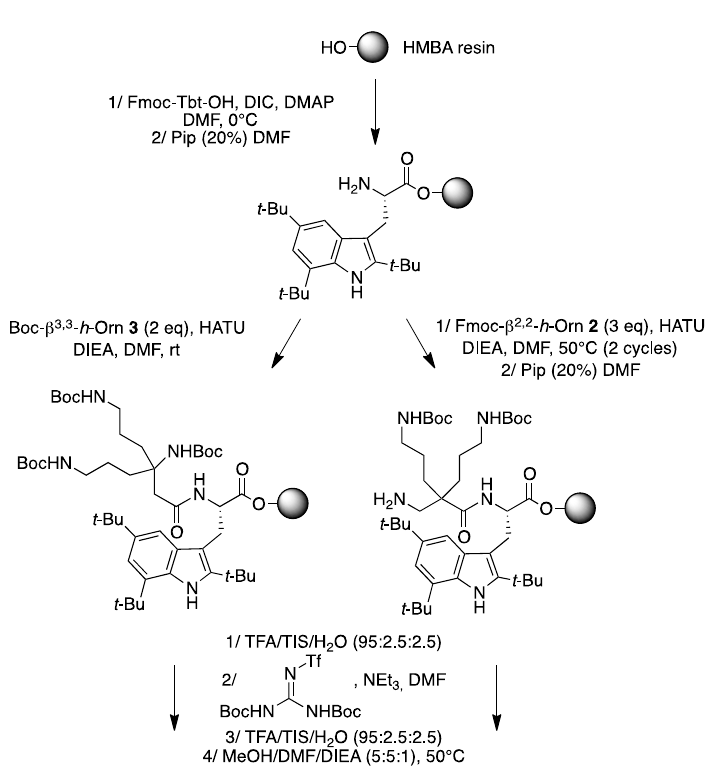
Figure 17 . HPLC profile of Gdm- β 2,2 -h-bis-Arg-Tbt-OMe 14 .